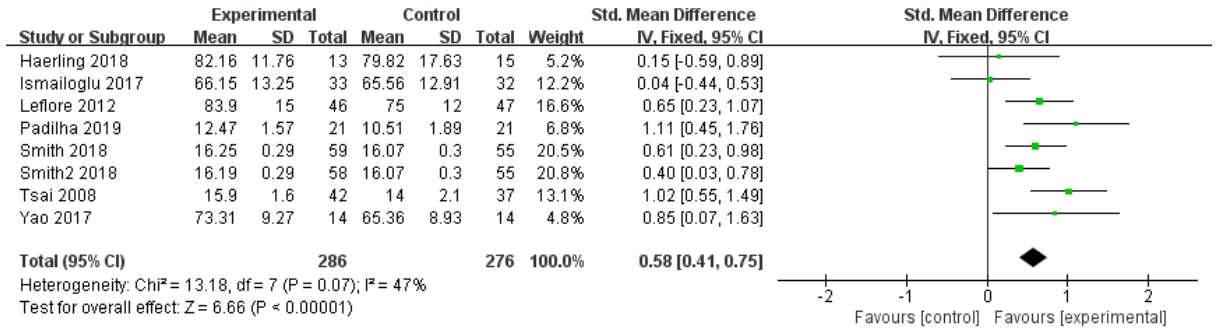
Figure 4. Forest plot of virtual reality on knowledge.